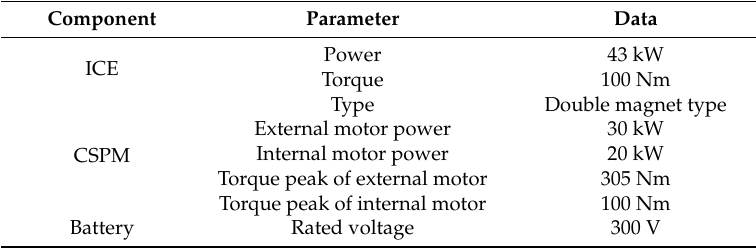
Table 2. The main component parameters of